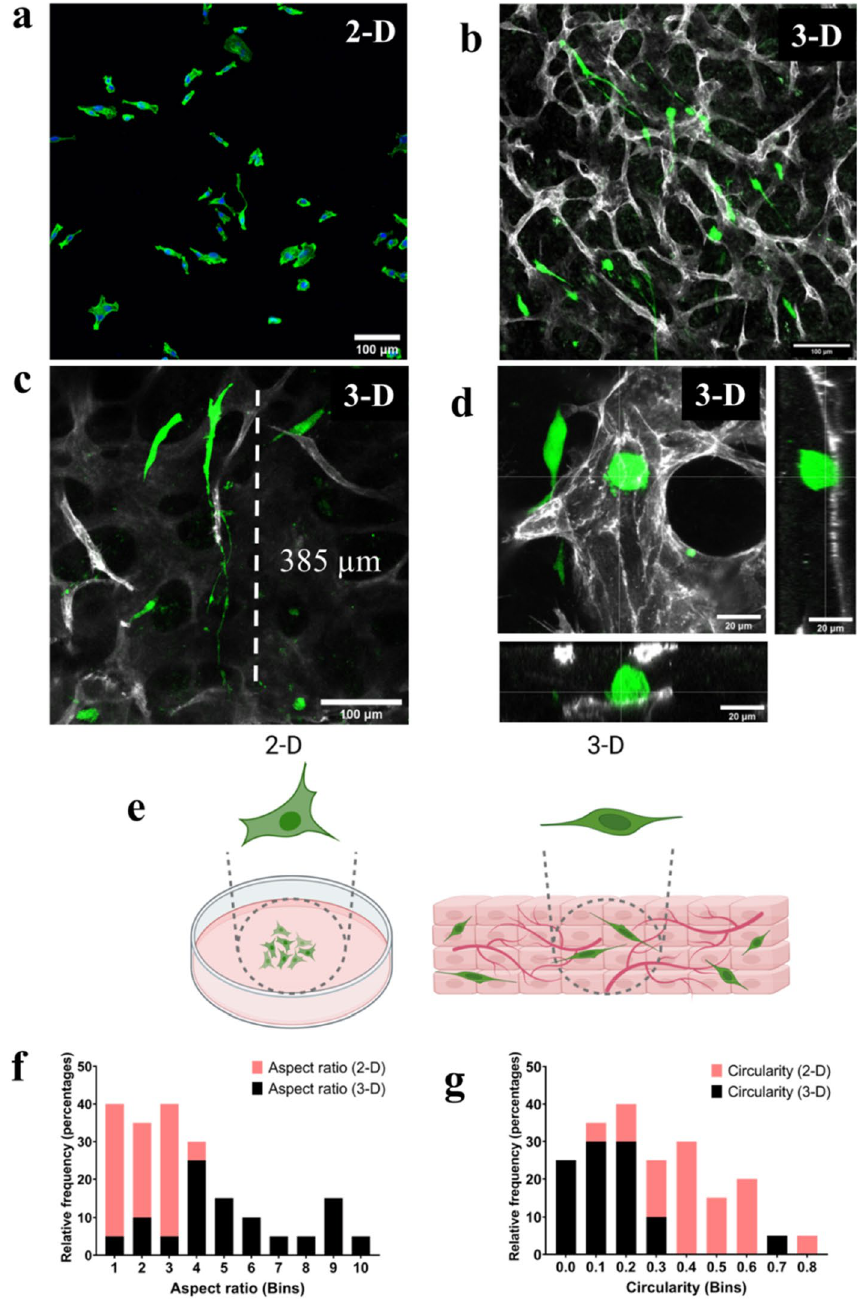
Figure 1. Formation of in-vitro vascularized breast cancer tissue. ( a ) Morphology of GFP + MDA-MB231 (green) in 2-D cell culture plate, Scale = 100 µm, ( b ) morphology of GFP + MDA-MB231 embedded in scaffold- free vascularized tissue, vessels were stained (grey) with PECAM1 (CD-31), Scale = 100 µm, ( c ) highly elongated BCCs filopodia observed in 3-D tissues wrapped around a vessel branch, Scale = 100 µm, ( d ) direct interaction between cancer cells and BVs, orthogonal projections are shown, ( e ) pictorial representation of the change of morphology of MDA-MB231 in 2-D culture and 3-D scaffold-free culture, ( f ) cell aspect ratio in 2-D is in the lower range as compared to cells in the 3-D models that range from low to high (data from randomly selected 20 cells from 3 samples), ( g ) cell circularity (1 = circular, 0 = elongated) analysis show that cells in 3-D tend to be more elongated as compared to 2-D cultures (randomly selected 20 cells from 3